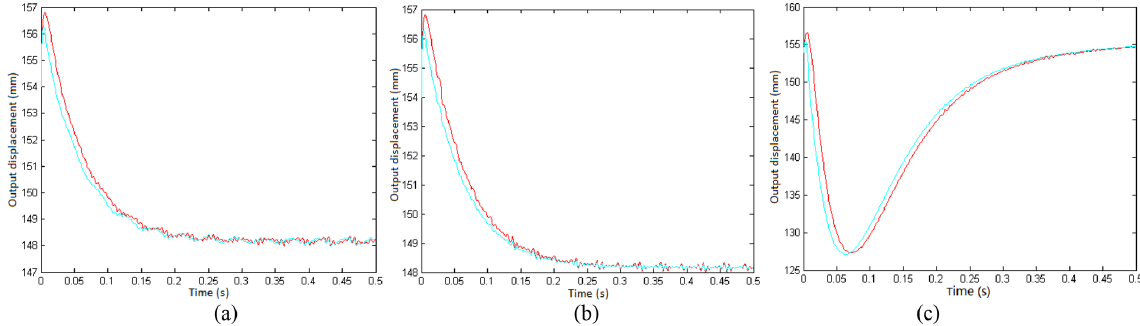
Figure 11. Influence curves of joint connection stiffness on the synchronisation of the servo controller. Variation curves under (a) alternating load, (b) step load and (c) impact